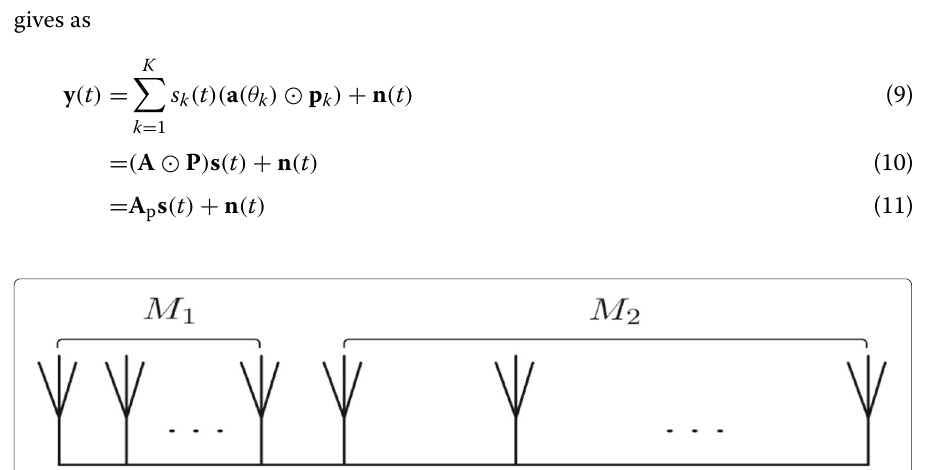
Fig. 2 A nested linear array consists of two concatenated ULAs with M 1 and M 2 EMVSs,